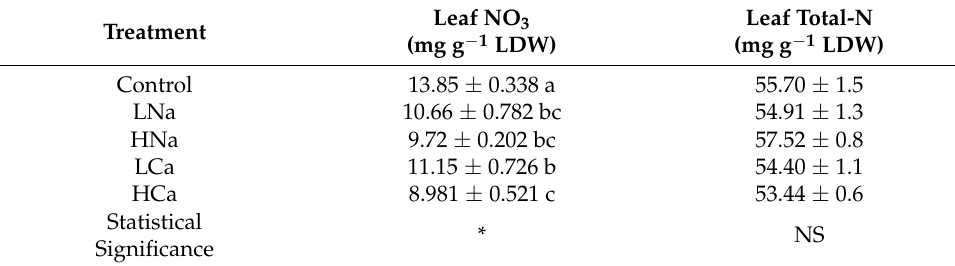
Table 1. Nitrate (NO 3 ) content and Total-N content (mg g − 1 of dry weight (LDW)) in the leaves of Valerianella locusta plants grown in a floating system, as influenced by four salinity treatments (referred to as low and high salinity level) and the salinity source. Control: standard nutrient solution ( − 0.08 MPa, 20 ◦ C); LNa: low NaCl-salinity ( − 0.18 MPa, 20 ◦ C); HNa: high NaCl-salinity ( − 0.28 MPa, 20 ◦ C); LCa: low CaCl 2 -salinity ( − 0.018 MPa, 20 ◦ C); HCa: high CaCl 2 -salinity ( − 0.28 MPa, 20 ◦ C).